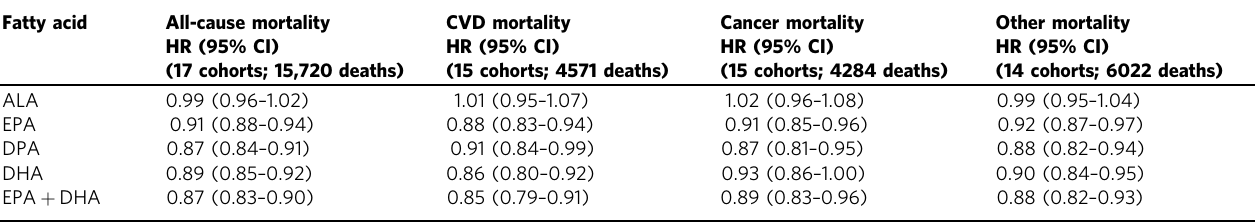
Table 2 Associations of circulating n-3 PUFA biomarkers with risk of total and cause-speci fi c mortality in 17 cohorts: Fatty Acids and Outcomes Research Consortium.